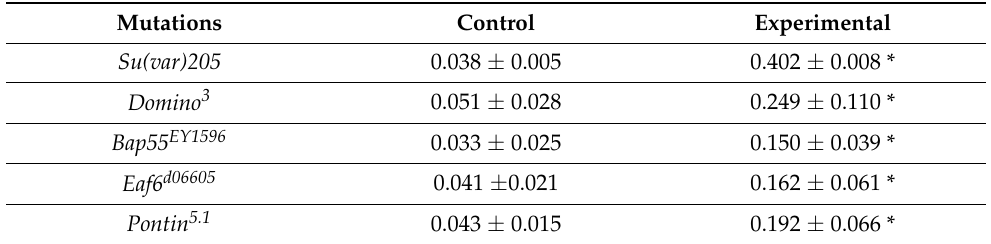
Figure 5. Dominant suppression of In(1)wm4 variegation by mutations in Bap55, Eaf6 , and Pontin genes. ( A ) Standard In(1)wm4 variegated phenotype (control); ( B ) Dominant suppression of In(1)wm4 variegation by Su(var2)05 and ( C ) Dom3 mutants (positive controls). Dominant suppression of In(1)wm4 variegation by ( D ) Bap55 EY1596 , ( E ) Eaf6 d06605 , and ( F ) Pontin 5.1 mutant alleles. ( G ) Quantifi- cation of PEV suppression in terms of O.D. Red histograms = eye pigment in presence of the tested mutations; white histograms = controls. p value <0.05 (*) or p value <0.0005 (***), compared with the control group. Table 5. Suppression of In(1)w m4 variegation. The results are expressed as % mean ± SD values from three independent replicate experiments. * = p < 0.05, compared to the